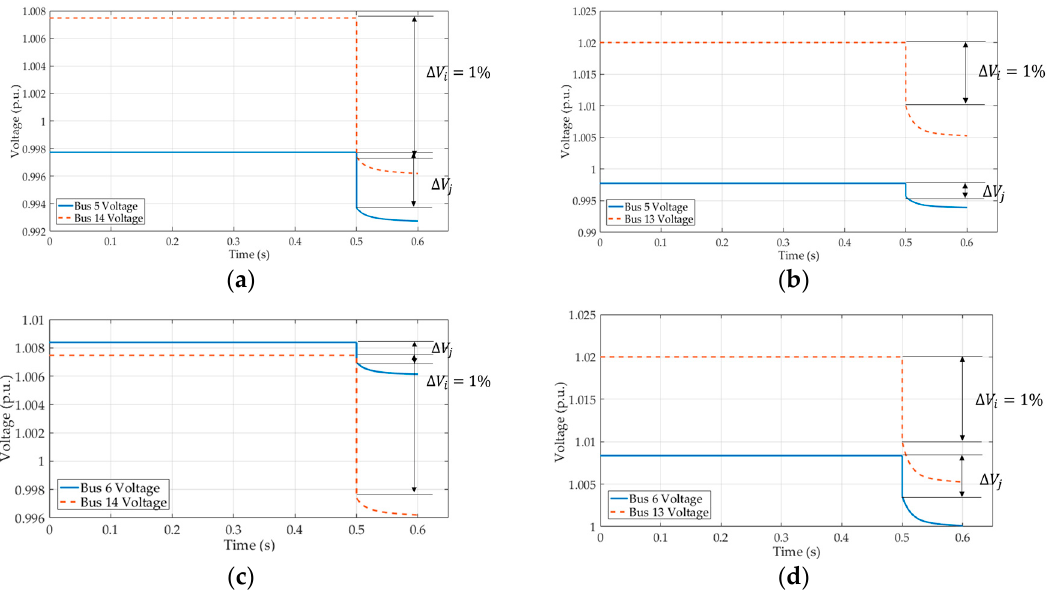
Figure 5. Test system case 1 MIIF simulation result by dynamic method: ( a ) MIIF1 simulation result; ( b ) MIIF2 simulation result; ( c ) MIIF3 simulation result; and ( d ) MIIF4 simulation result.